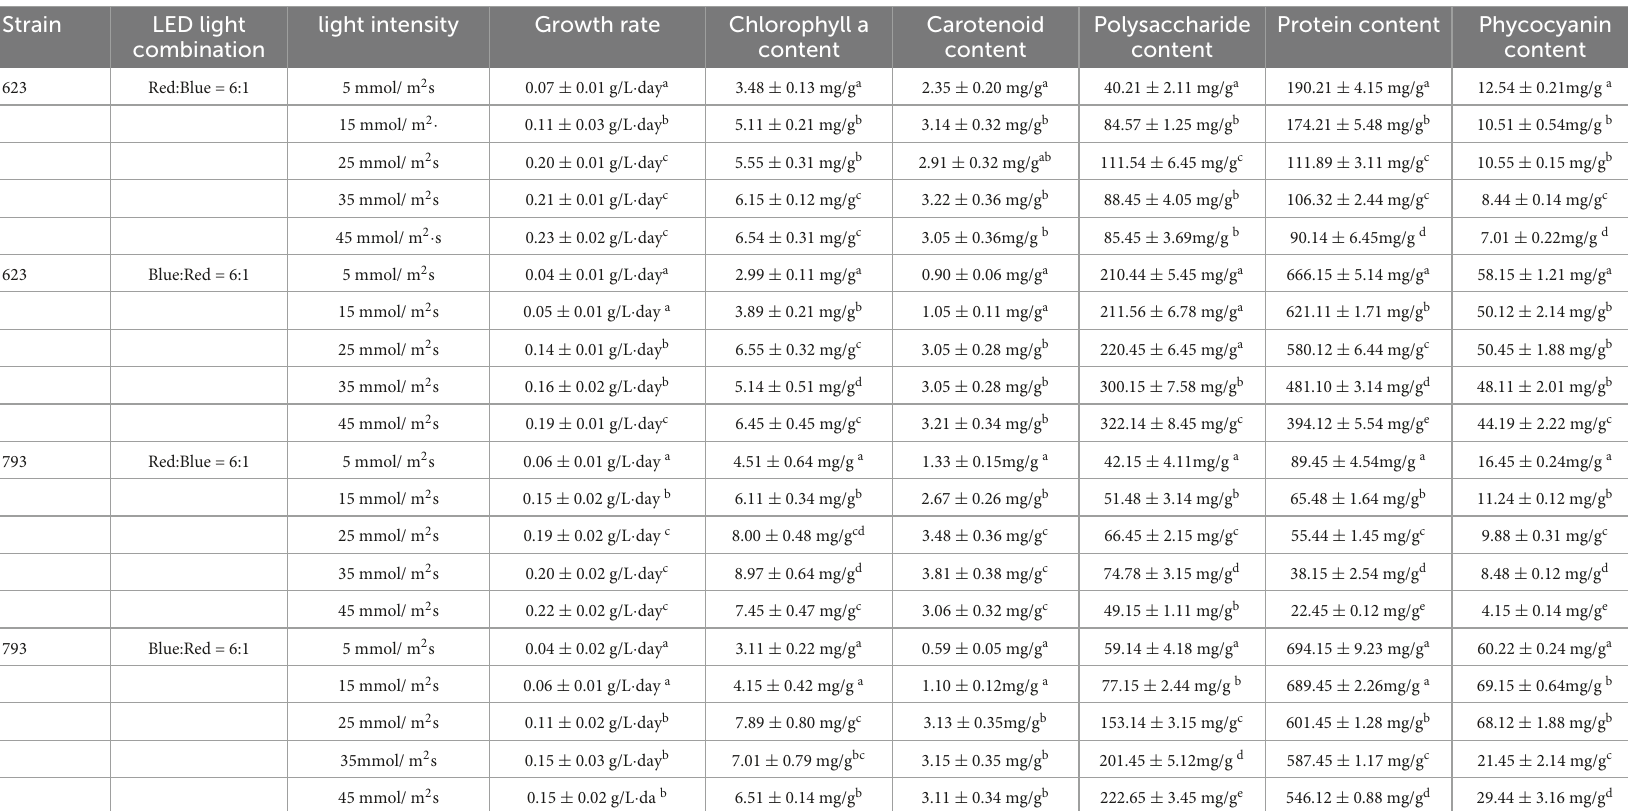
TABLE 4 Growth rate and organic matter content of Arthrospira platensis OUC623 and A. platensis OUC793 under different light